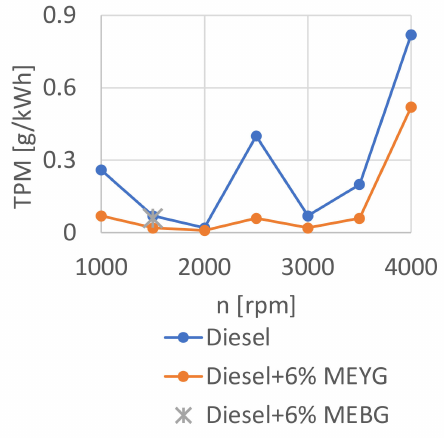
Figure 13. The total emissions of PM at full engine